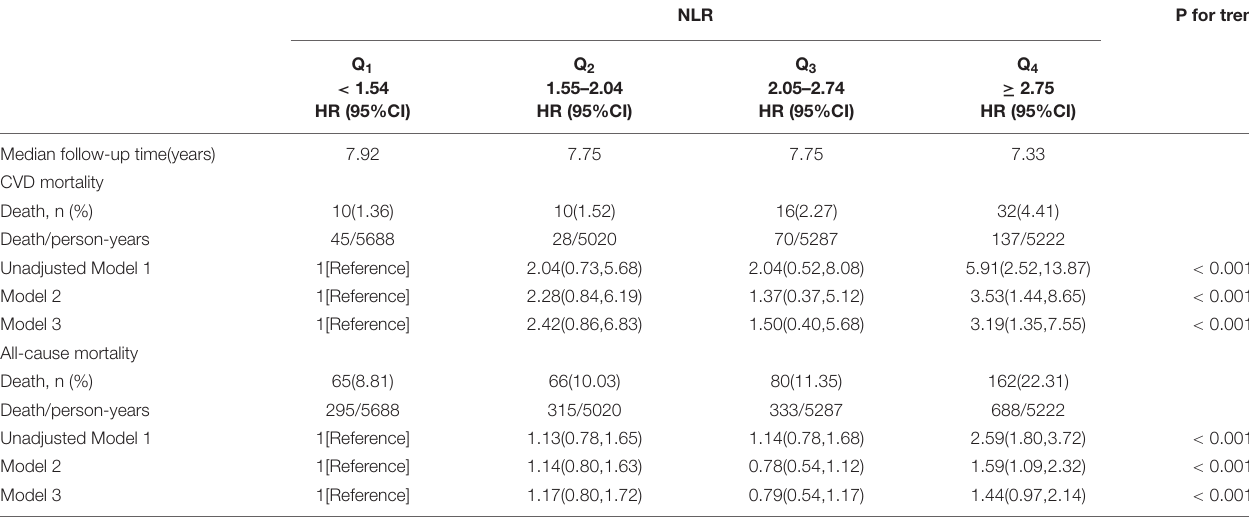
TABLE 2 | Multivariate Cox regression analysis of NLR with CVD and cause-specific mortality.